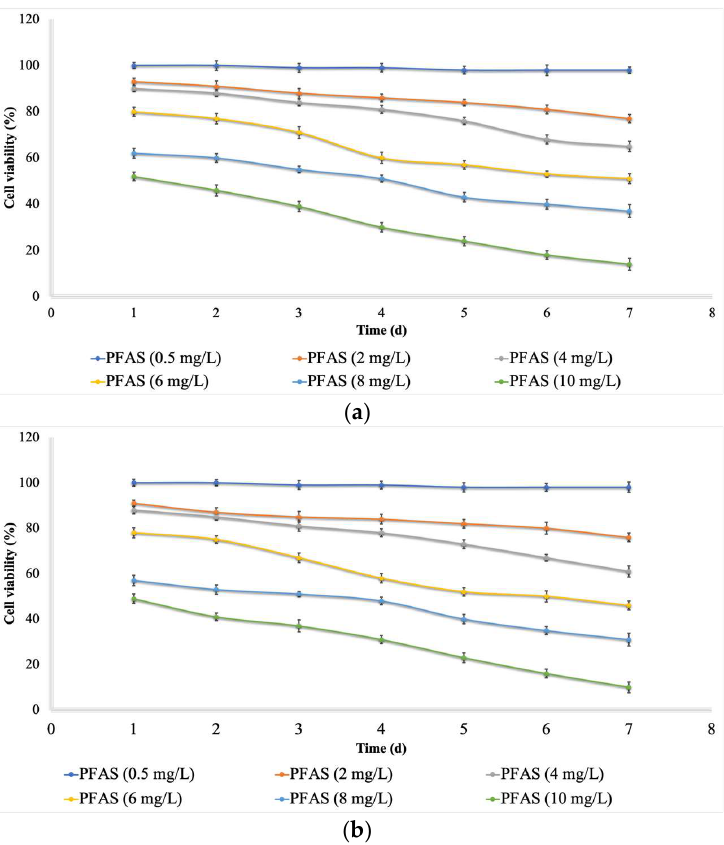
Figure 1. Cell viability (%) in different concentrations of PFAS (mean ± error, n = 3); ( a ) for Chlorella vulgaris and ( b ) for Scenedesmus obliquus.